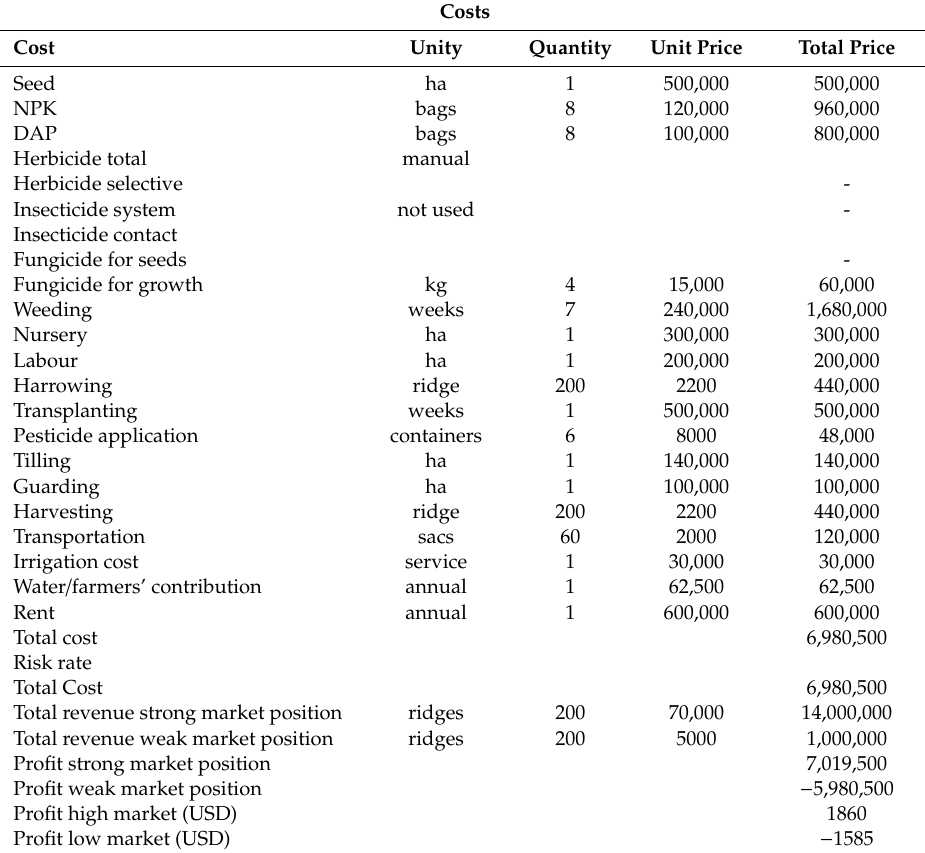
Table A3. Cost-benefit analysis of onion production (in UGX) in Mubuku,